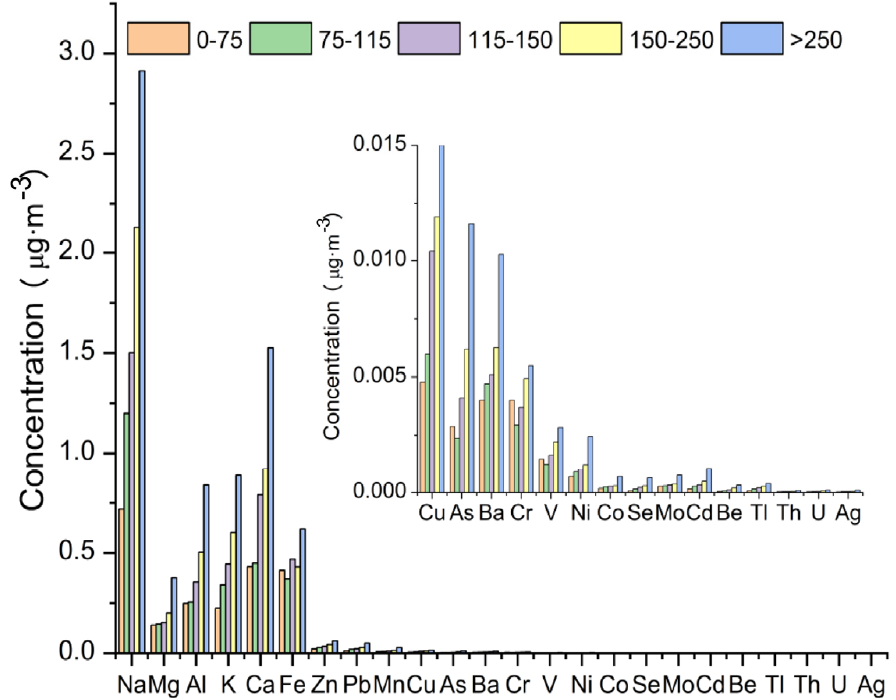
Figure 6. Mean concentrations of inorganic elements (IEs) in PM 2.5 during different air qualities in Shihezi.